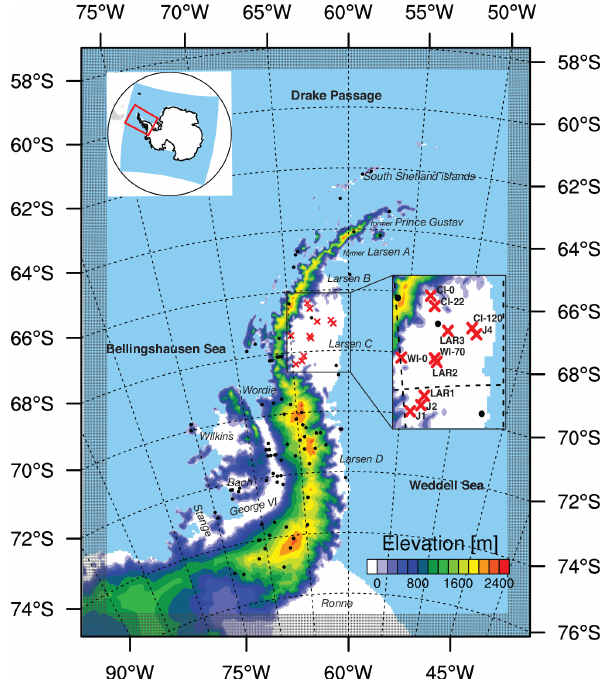
Figure 1. RACMO2 model domain (red box in inset map of Antarc- tica) and surface topography ( m ) of the Antarctic Peninsula. Lo- cations of 10m snow temperature observations are marked (black dots) as well as the density profiles (red crosses). Model topogra- phy is based on digital elevation models described in Van Wessem et al. (2018). White areas represent the floating ice shelves; coloured contours represent the grounded ice